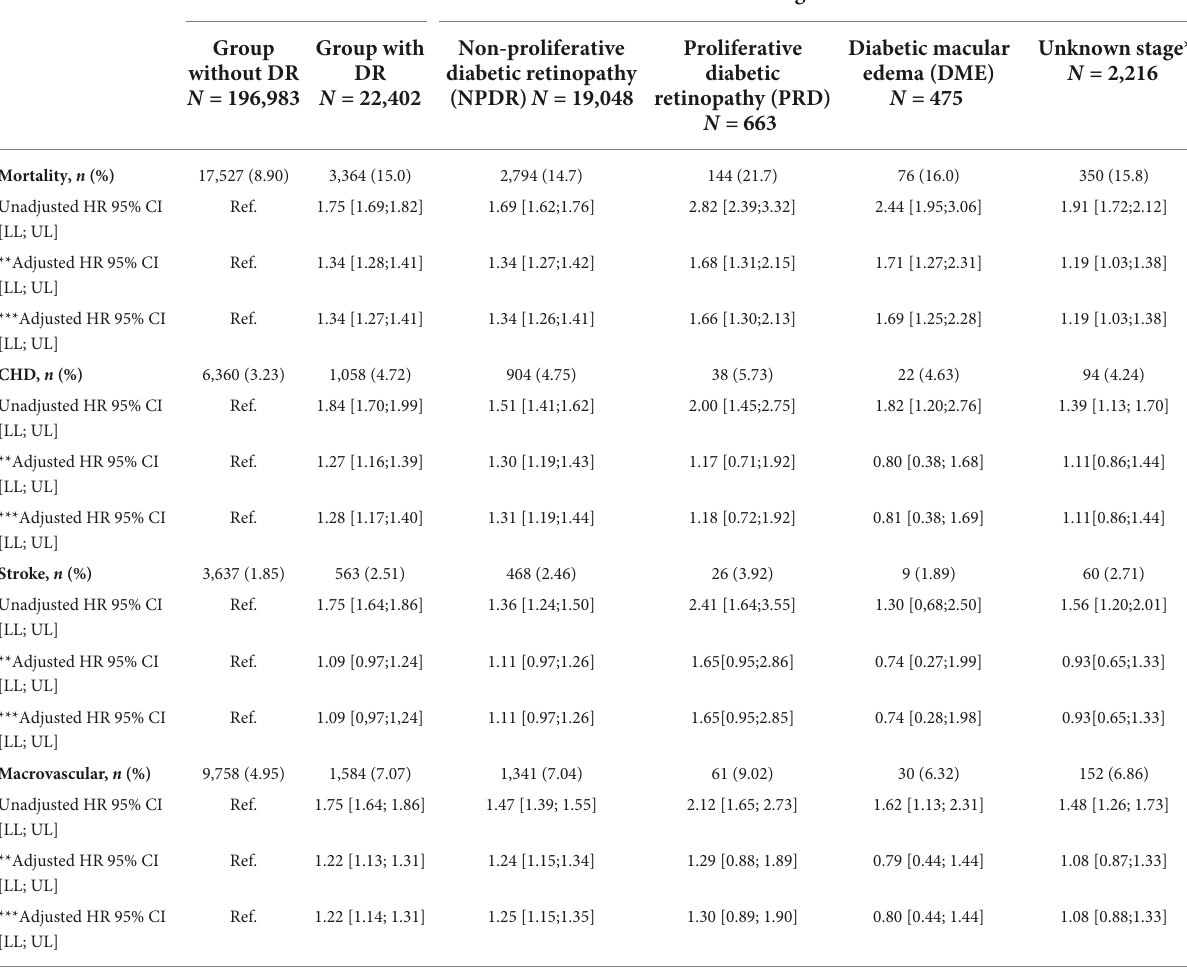
TABLE 3 Hazard ratios for events among the study groups complete cases